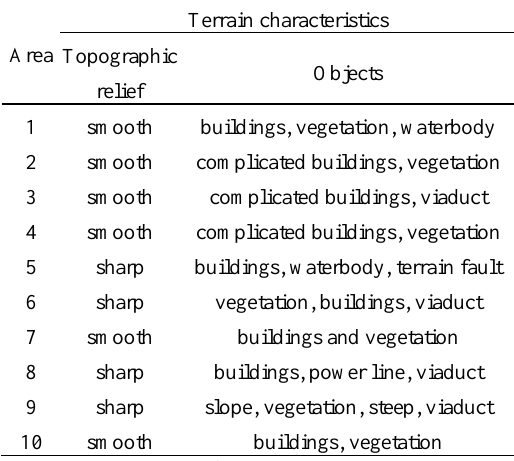
Table 1. Topological relief and main terrain types in test